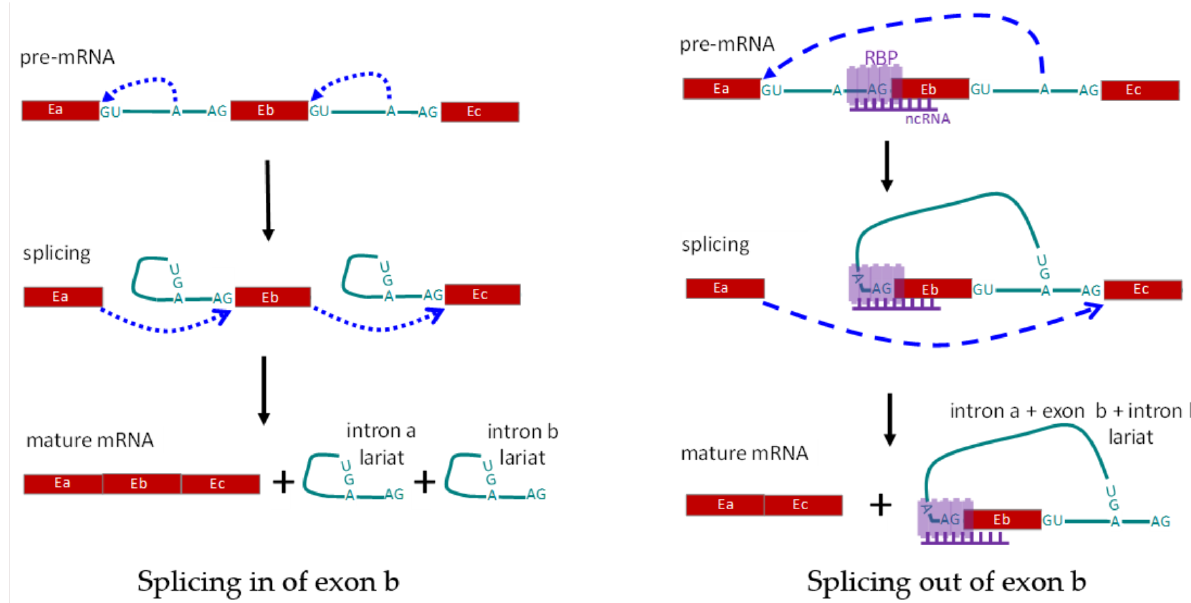
Figure 3. Schematic diagram showing regulation of alternative splicing in trans -act. Left panel shows the normal splicing to include all three exons. Right panel shows exclusion of exon Eb, due to alternative splicing mediated by RNA-binding protein(s), RBP(s), and non-coding RNA. E: exon; A: branch site for RNA splicing; RBP: RNA-binding protein(s); ncRNA: non-coding RNA complementary to the